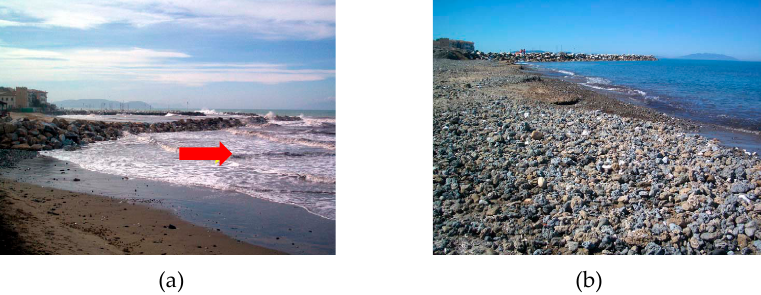
Figure 10. North harbor area (sector 134). (a) The red arrow shows the reflected wave by the breakwater during the working phase in 2006; (b) beach rock fragments that have been dredged during the reshaping of the harbor and used to nourish the erosive spot at sector 134 [40].